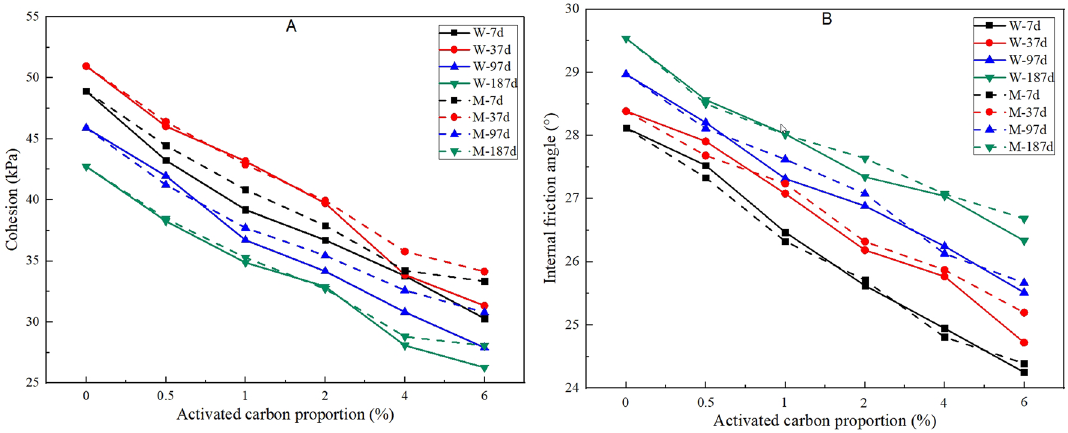
Figure 7. Effect of activated carbon on the cohesion ( A ) and internal friction angle ( B ) of vegetation